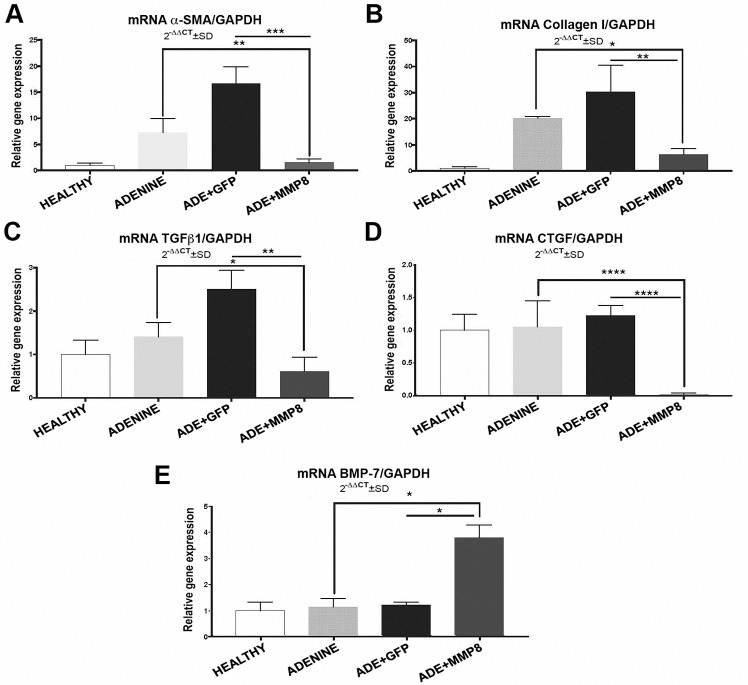
mRNA levels of profibrogenic and anti-fibrogenic genes.A-D) Fold change in gene expression indicates that adhMMP8 treatment clearly decreased αSMA, Col1A1, TGFβ1 and CTGF mRNA levels; and increases E) BMP7 mRNA values compared to controls. (*p<0.05, **p<0.01, ****p<0.0001).